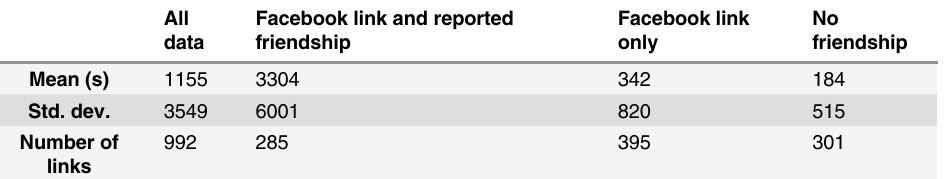
Table 8. Mean and standard deviation of distribution of aggregate durations for different sets of links. Only 11 pairs of students have a reported friendship but no Facebook links, so that we do not give the corre- sponding